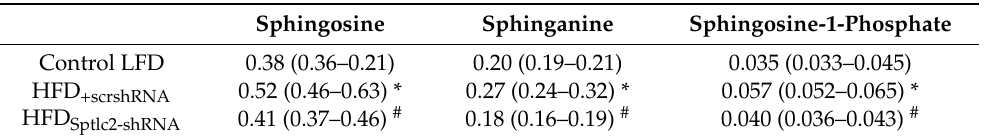
Table 3. The Impact of Sptlc2 Silencing on the Content of Sphingosine, Sphinganine and Sphingosine- 1-Phosphaate in the Mouse Gastrocnemius